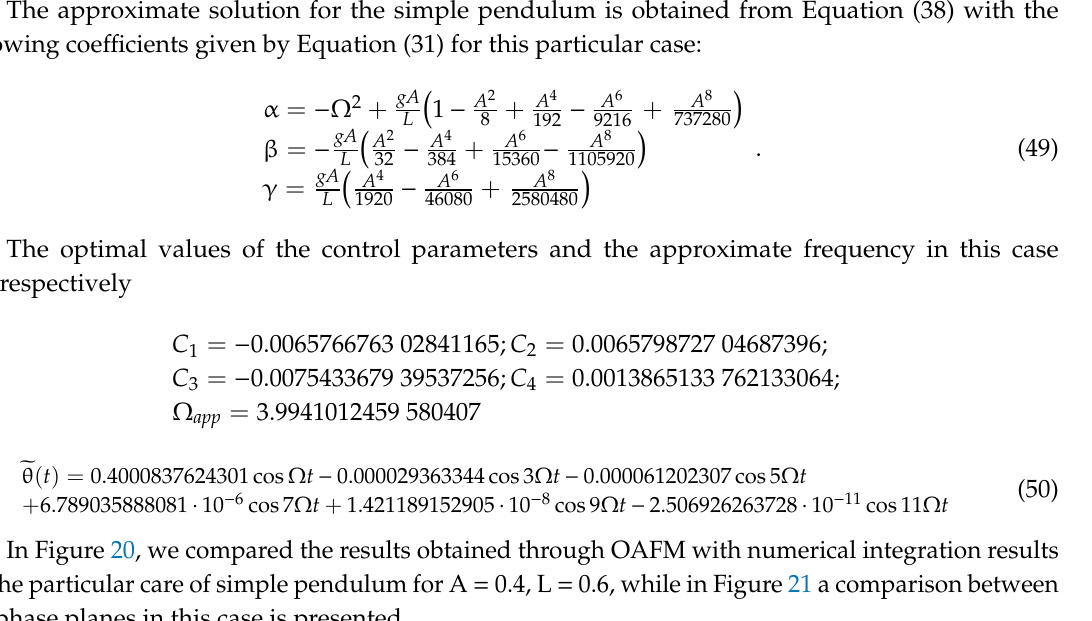
Figure 20. Comparison between the approximate solution (50) and numerical integration results for A = 0.4, L = 0.6.